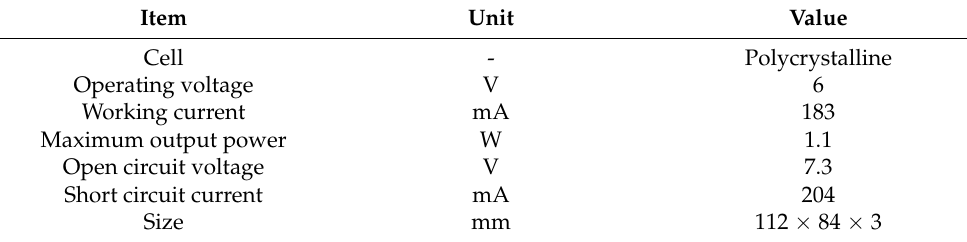
Table 2. PV panel